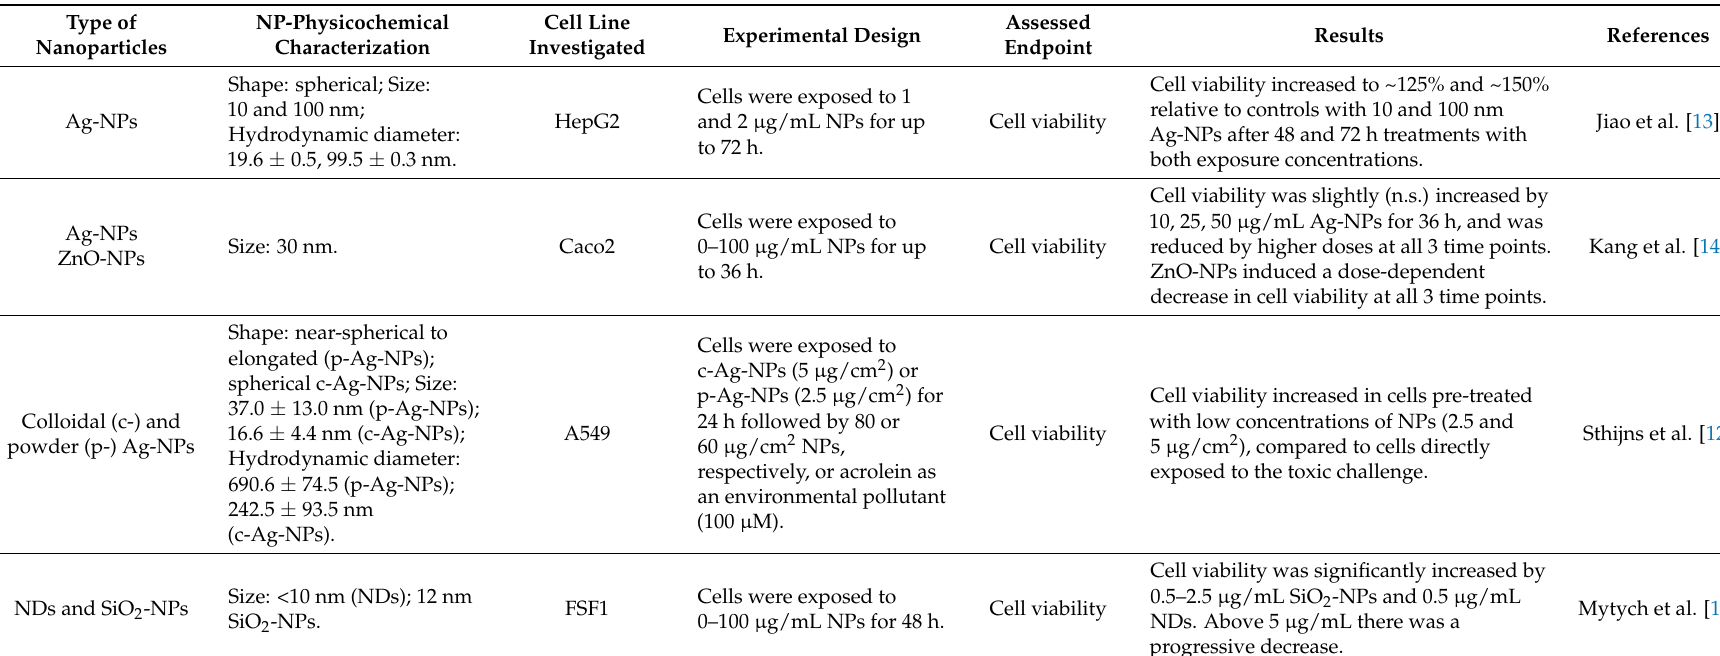
Table 1. In vitro studies demonstrating the presence of a nanoparticle induced hormetic